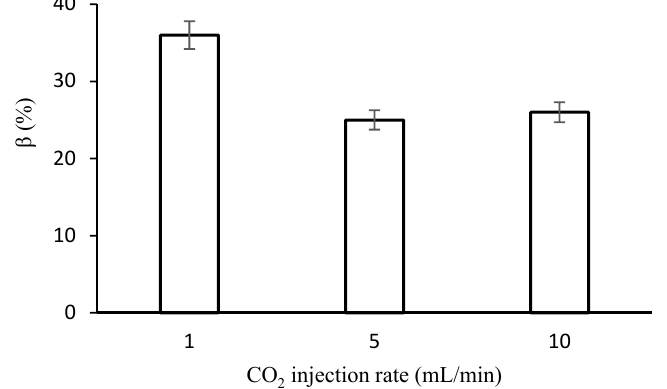
Figure 5. Effect of drying and salt precipitation on CO 2 injectivity. Injectivity impairment, β increased with decreasing CO 2 injection rate .